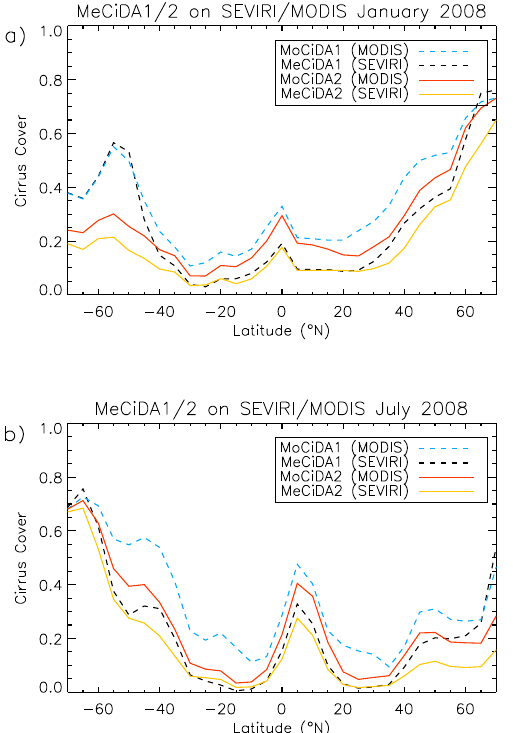
Fig. 9. Mean cirrus cloud cover during January 2008 (a) and July 2008 (b) over the selected region derived from SE- VIRI (black/yellow) and MODIS (turquoise/red) using MeCiDA and MoCiDA, before (dashed lines) and after (solid lines) the